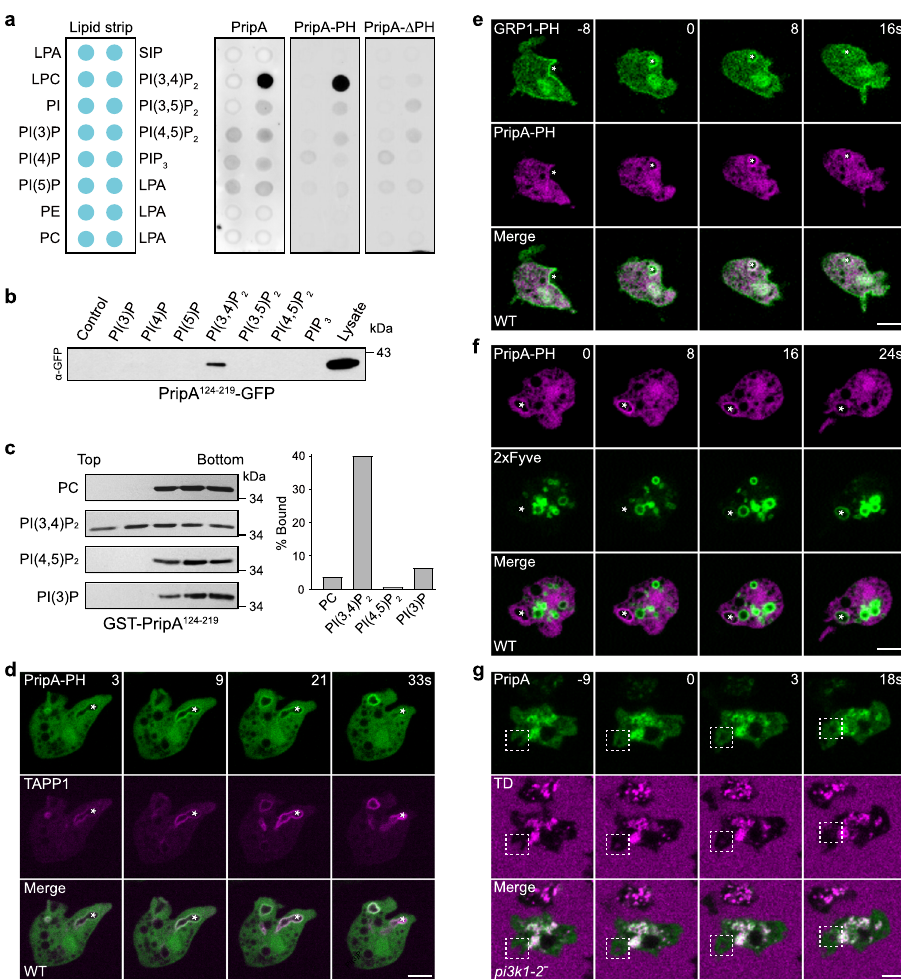
Fig. 3 The PH domain of PripA interacts with PI(3,4)P 2 . a Lipid dot blot assay using cell lysates expressing GFP-tagged PripA, PripA-PH, or PripA- Δ PH. b Cells lysates expressing PripA 124-219 -GFP were incubated with the indicated lipid-coated agarose beads. Proteins eluted from the beads were probed with anti-GFP antibody. Lysate (0.8%) was loaded as input. c Left: liposome fl otation assay with puri fi ed GST-PripA 124-219 . Proteins bound to liposomes were fl oated to the top of a sucrose gradient, from which fi ve fractions were collected and analyzed by silver staining. Right: quanti fi cation of liposome binding. d Colocalization of PripA-PH-GFP and TAPP1-RFP on nascent macropinosomes. The Pearson ’ s correlation coef fi cient was 0.71 ± 0.09 (mean ± SEM, n = 8 cells), where 1 = perfect, 0 = no correlation, and − 1 = excluded. e Sequential accumulation of GRP1-PH-GFP and PripA-PH-RFP during macropinocytosis. f Sequential accumulation of PripA-PH-RFP and GFP-2 × Fyve during macropinocytosis. g Localization of PripA-GFP in pi3k1-2 − cells incubated with TD. Nascent macropinosomes are marked by asterisks ( d – f ) or dashed boxes ( g ). Scale bar = 5 μ m. Data in a – c was from one representative experiment out of two independent experiments. Source data for a – c are provided in this